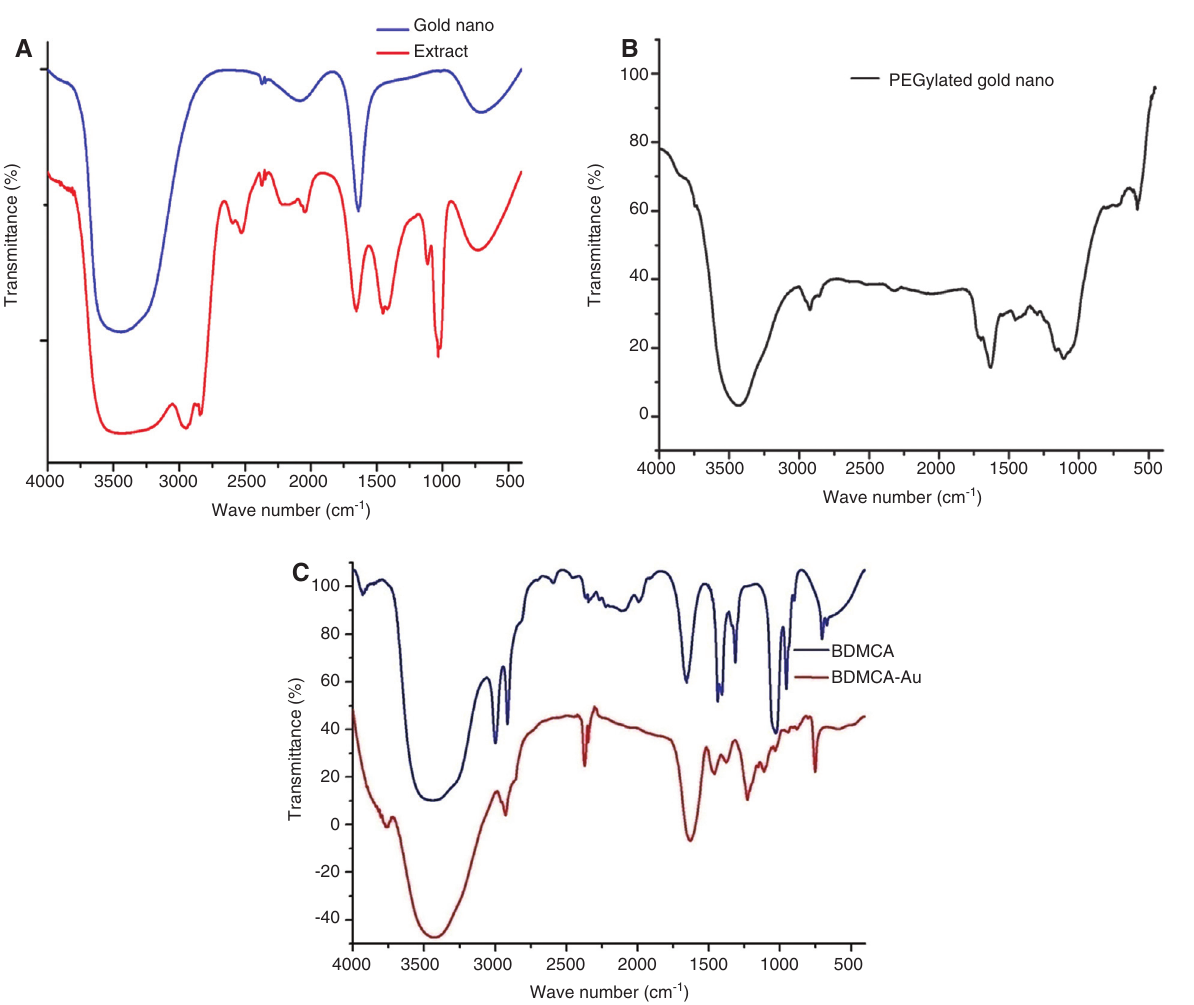
Figure 11 Fourier transform infrared spectroscopy (FTIR) spectrum of (A) extract and as-prepared gold nanoparticles, (B) polyethylene glycol (PEG), (C) bisdemethoxycurcumin analog (BDMCA) and BDMCA coated gold